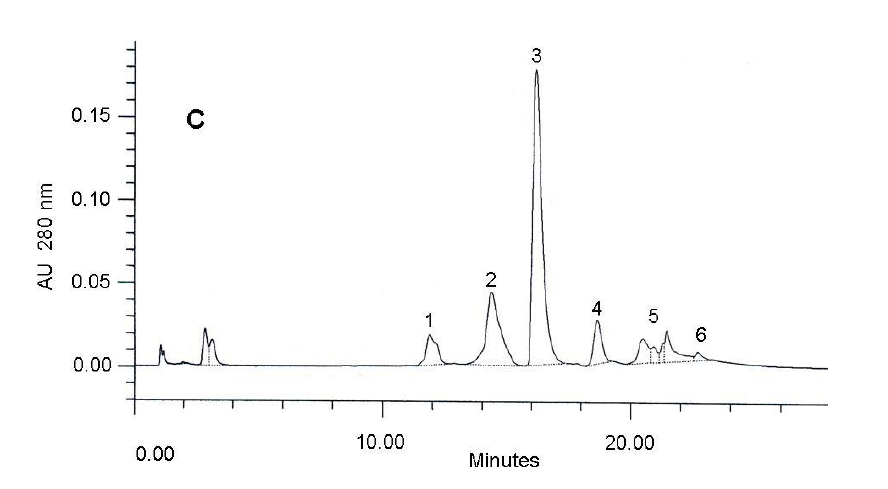
Figure 3. Reverse phase chromatographic protein profile of Crotalus durissus venom. Guajira male ( A ), Tolima female ( B ) and offspring pool ( C ). The retention times were 12 (1), 14 (2), 16 (3), 18 (4), 21 (5) and 23 (6) minutes.